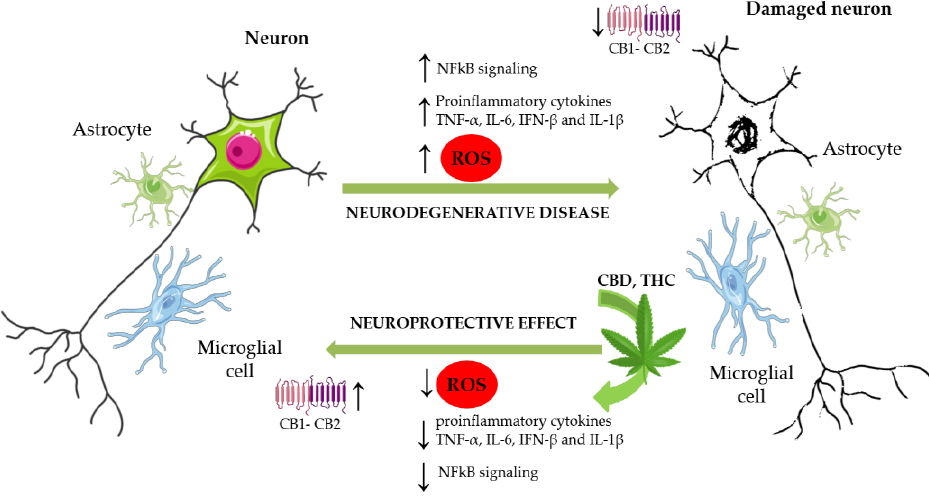
Figure 3. Cannabinoids and neurodegenerative diseases. In many neurological disorders there are incremented secretions of neurotoxic agents, such as ROS. The increment of ROS leads to NFkB activation and transduction, with the subsequent production of pro-inflammatory cytokines, such as TNF- α , IL-6, IFN- β and IL-1 β . In neurological disorders, the action of CBD and THC provides neuroprotective effects through antioxidant and anti-inflammatory properties and through the activation of CB1 and CB2 to alleviate neurotoxicity.